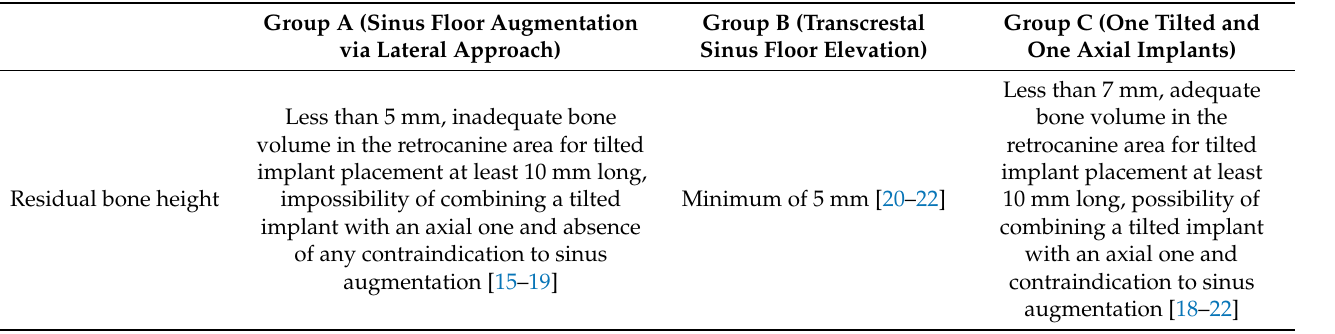
Table 1. Sample division according to residual bone height, bone volume in the retrocanine area, possibility or not of combining a tilted implant with an axial one, and presence or absence of any contraindication to sinus